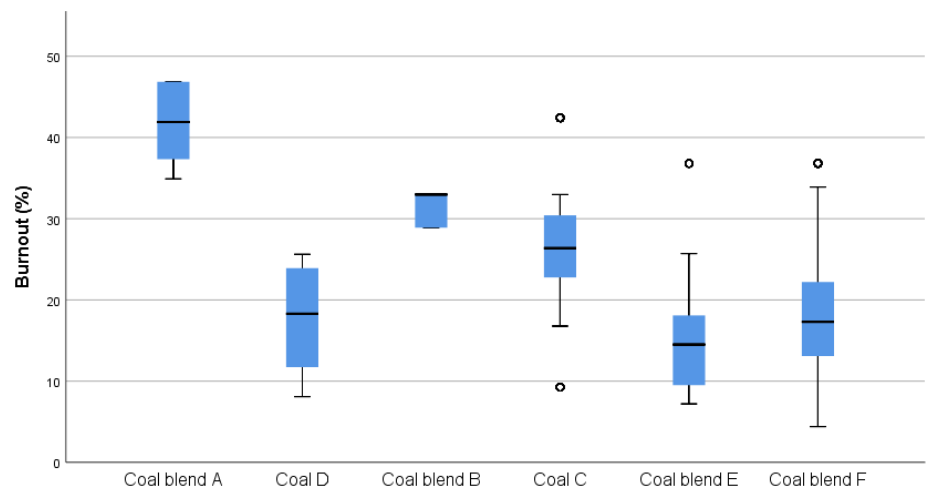
Figure 15. Range of coal burnout for each of the coals/coal blends used during observed blast furnace production ( ◦ = high/low potential outliers and * = high/low extreme values).